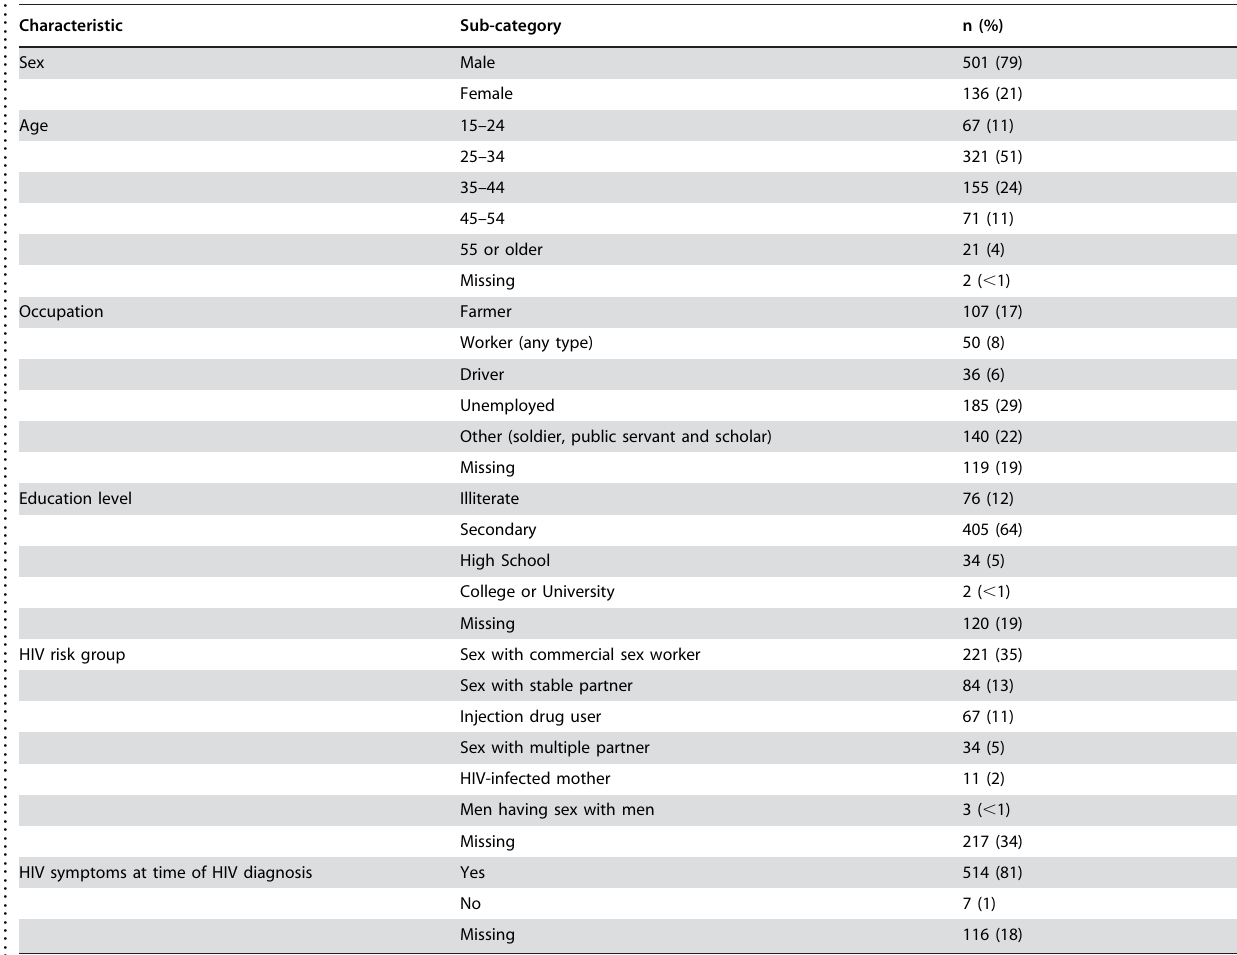
Table 1. Demographic characteristics of HIV-infected TB patients (N= 637) – An Giang, Vietnam, 2001 – 2004. .. ... .... ... ... .... ... ... .... ... ... .... ... ... .... ... ... .... ... ... .... ... ... .... ... ... .... ... ... .... ... ... .... ... ... .... ... ... .... ... ... .... ... ... .